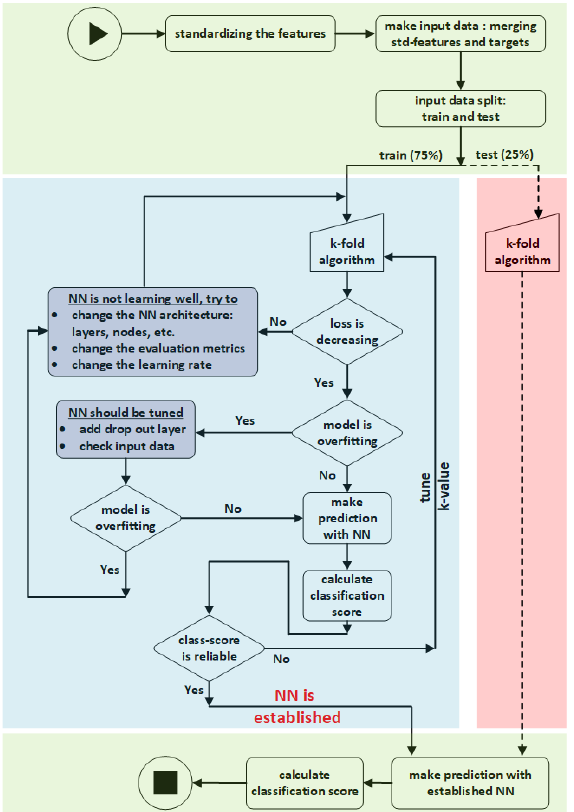
Figure 5. The flowchart illustrates establishing a NN using train data set and then validating the network with test data set.